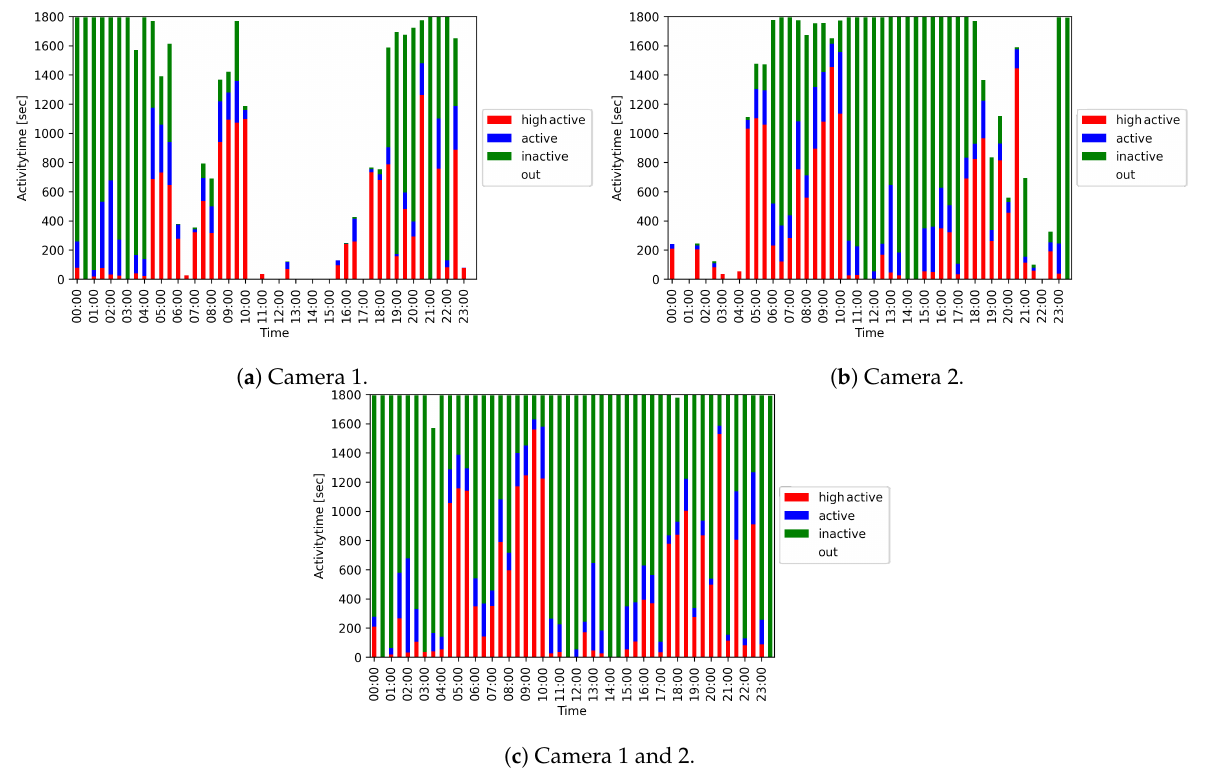
Figure 9. 24-h activity overviews of a fox depicted in 30 min time